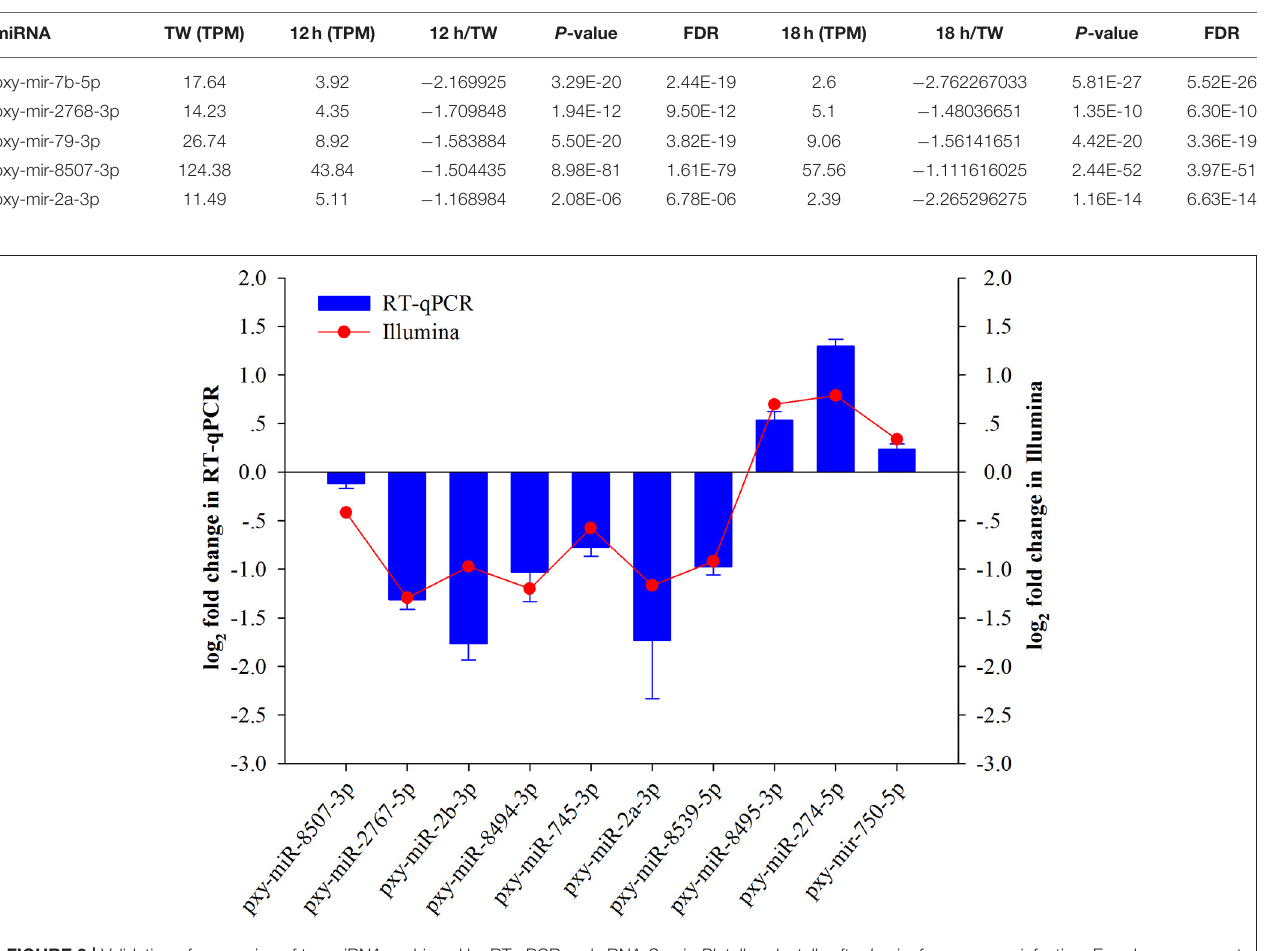
Frontiers in Physiology |